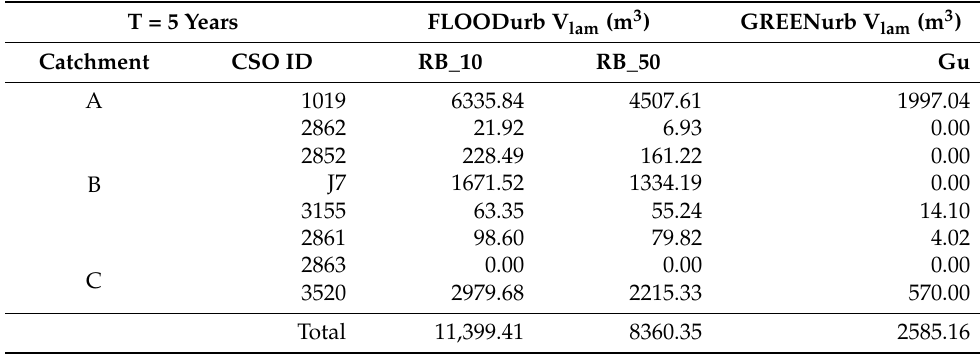
Table 6. Stormwater detention tanks volumes in the hybrid scenario for a 5-year return-period rainfall.